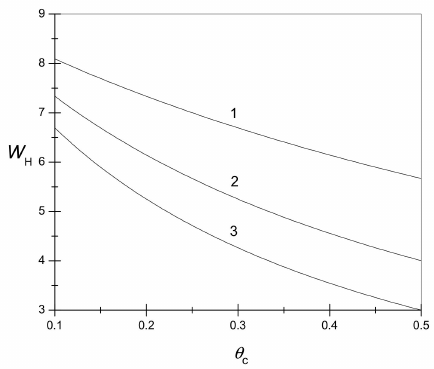
Figure 2. Dependence of W H on θ C at f 1 = 0.2; 1: f 2 = 0.4, 2: f 2 = 0.6, 3: f 2 = 0.8.